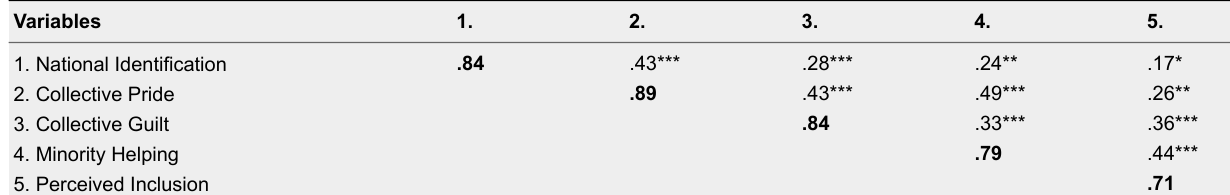
Correlations of Latent Variables and Squared Root of Average Variance Extracted (AVE) of the Latent Variables in the Study